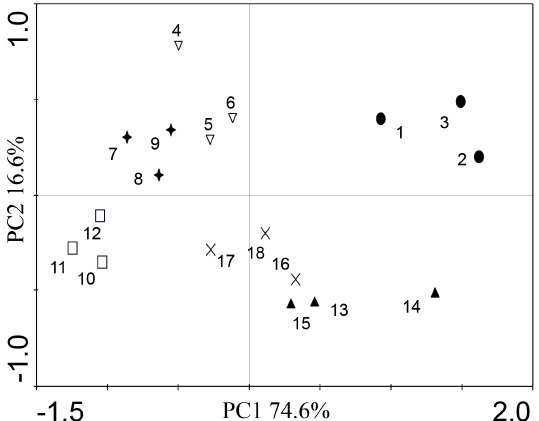
Figure 5. Principal component analysis of DSE colonization in different sampling times and sampling